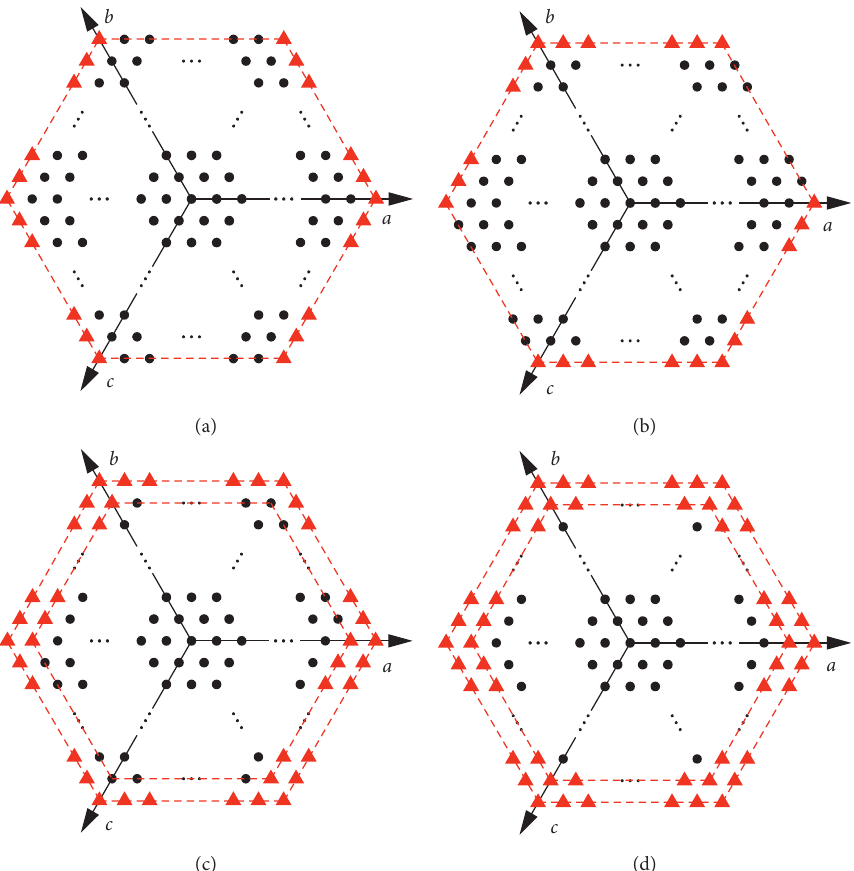
Figure 3: Effect of open-circuit problem to space vector. (a) One faulty cell in A. (b) One faulty cell in B. (c) One faulty cell in each of phase A and phase B. (d) One faulty cell in each of phase A, phase B, and phase C.